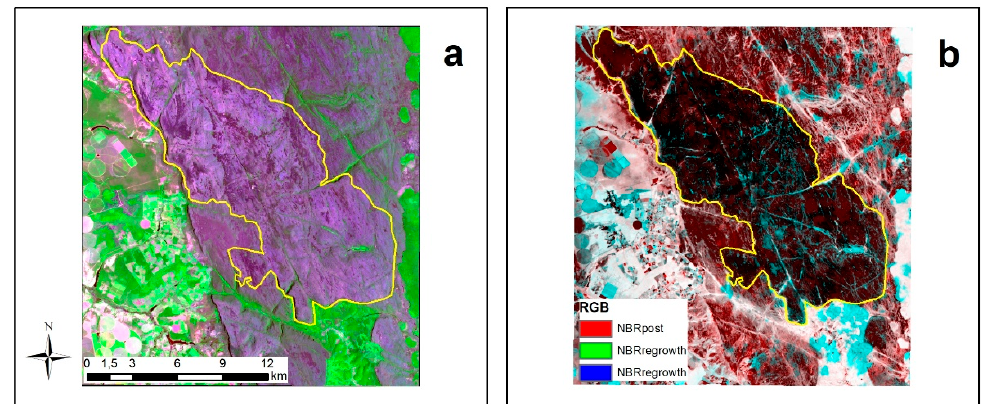
Figure 13. Pictures of: ( a ) colored composition image corresponding to the regrowth image for the Gerais do Machobongo fire; data from the Landsat-8 7-5-4 RGB OLI sensor; and ( b ) multitemporal visualization of the regrowth area (2016) corresponding to the Gerais do Machobongo fire, NBRpost//NBRregrowth/NBRregrowth RGB.